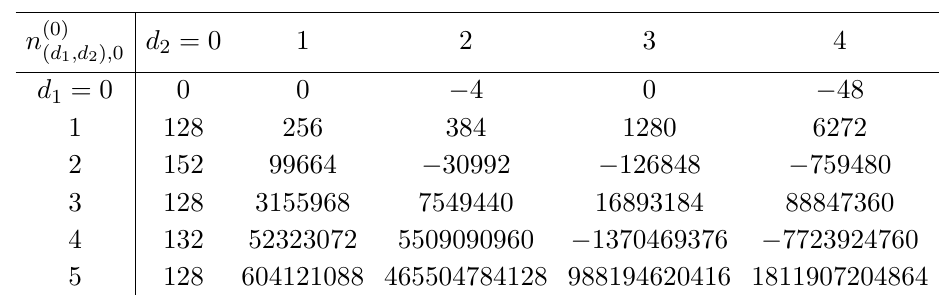
with Z charge 0 . 2 2